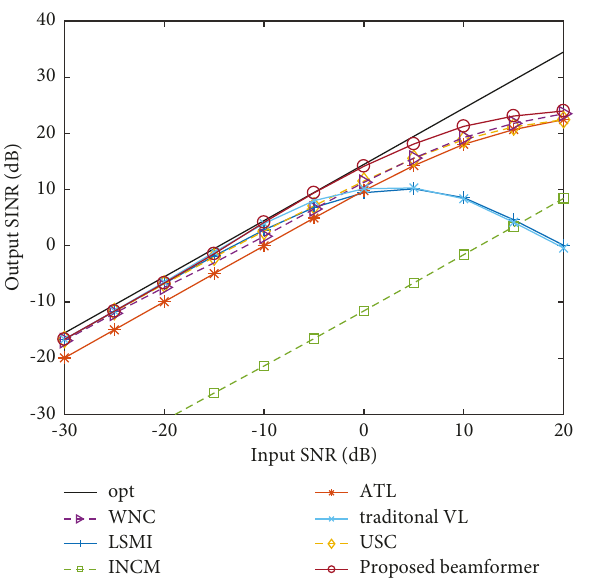
Figure 5: Output SINR versus the number of snapshots.